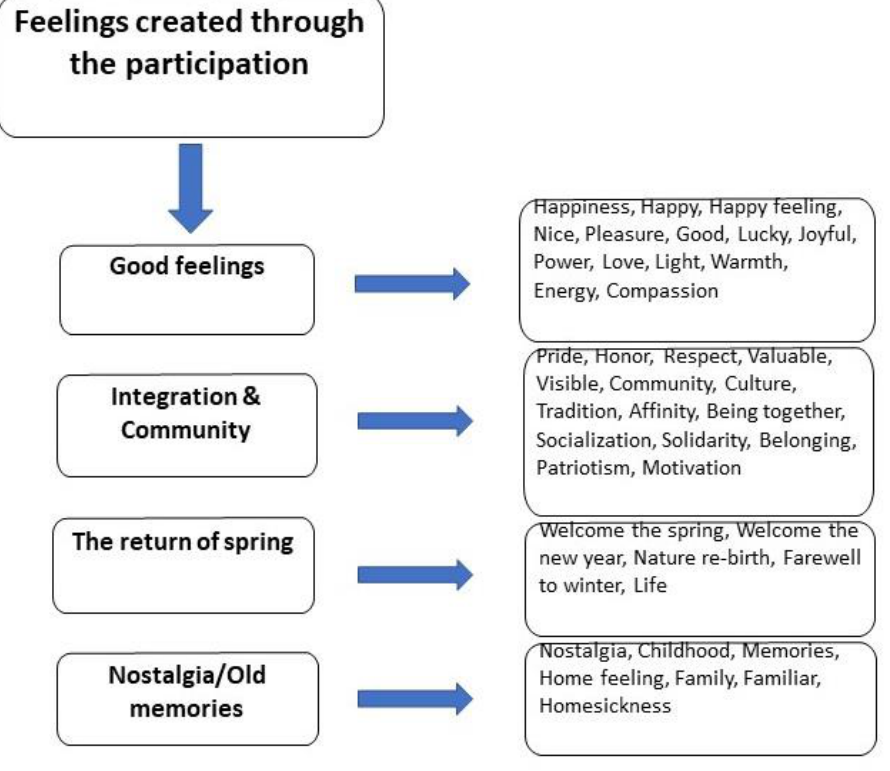
Figure 1. The four categories of meanings in the answers with related codes in each are illustrated by the author.